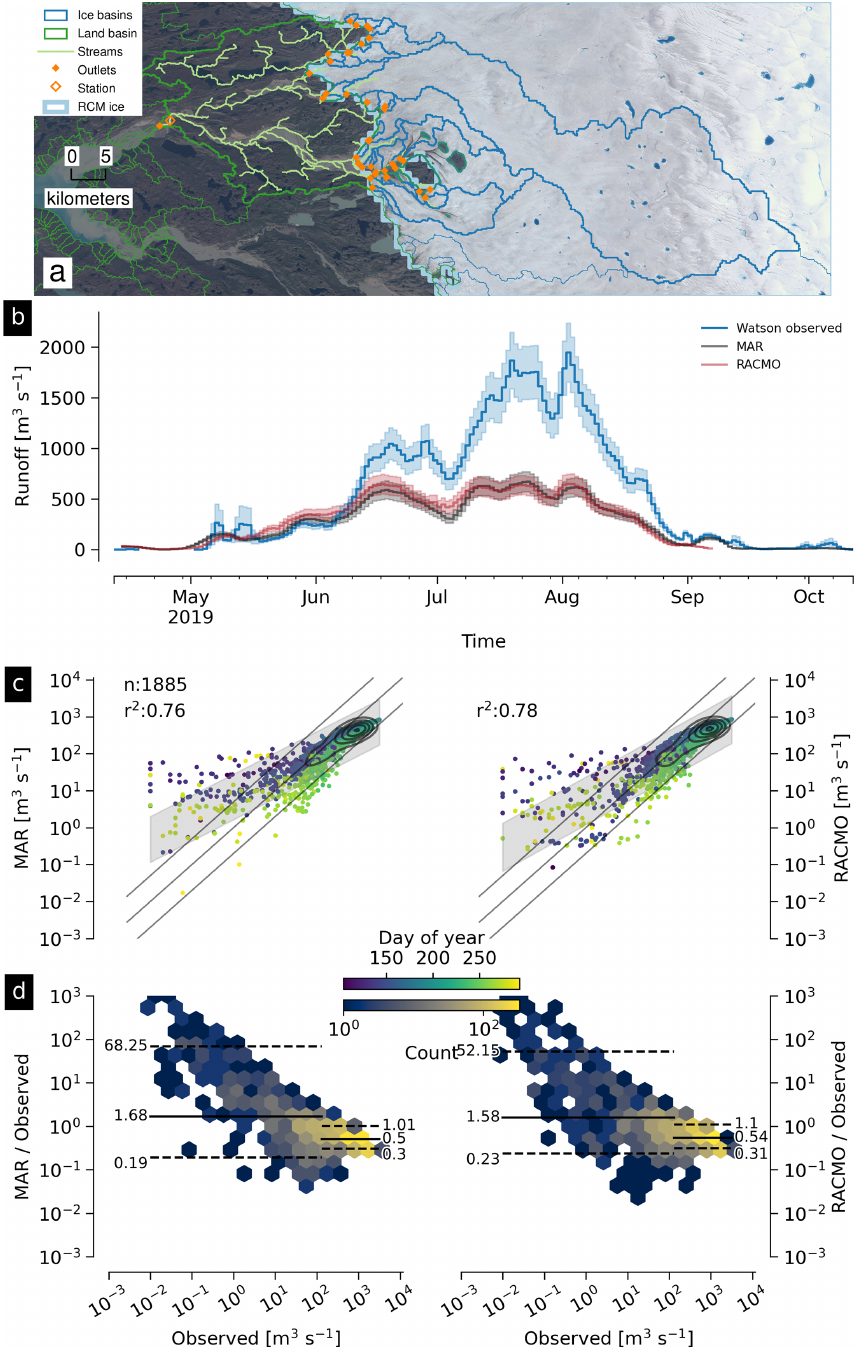
Figure 7. Graphical summary of Watson River outlet, basin, and discharge (W in Fig. 1). See Sect. 3.4 for a general overview of graphical elements and Sect. 4.2.2 for discussion of the Watson River basin. Basemap from Howat et al. (2014) and Howat